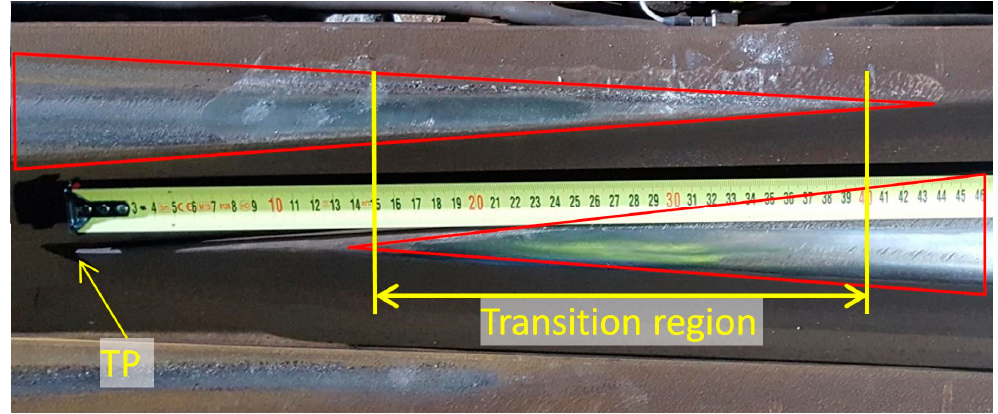
Figure 5. Transition region of the monitored crossing.